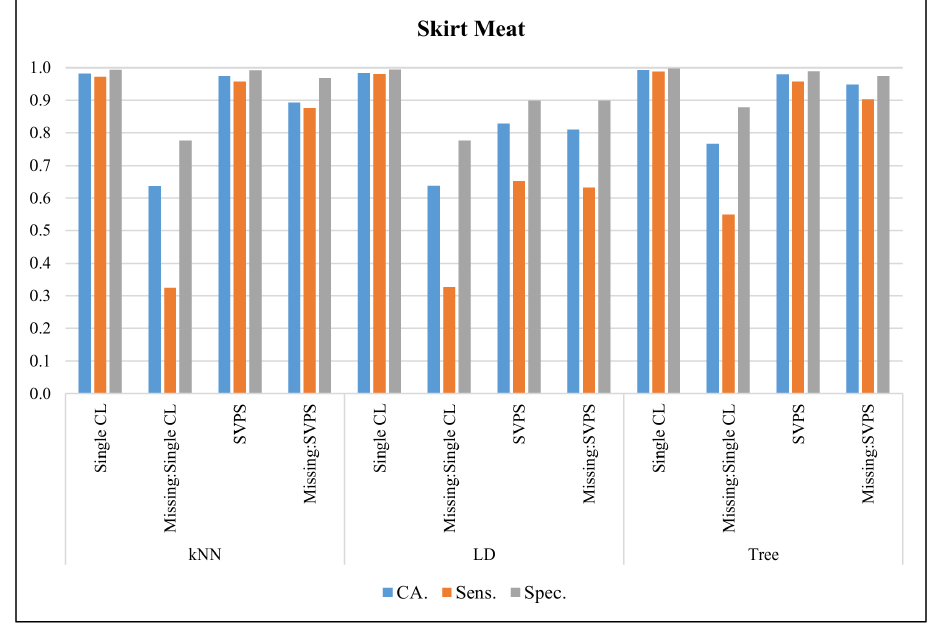
Figure 14. Classification results for Skirt Meat dataset.